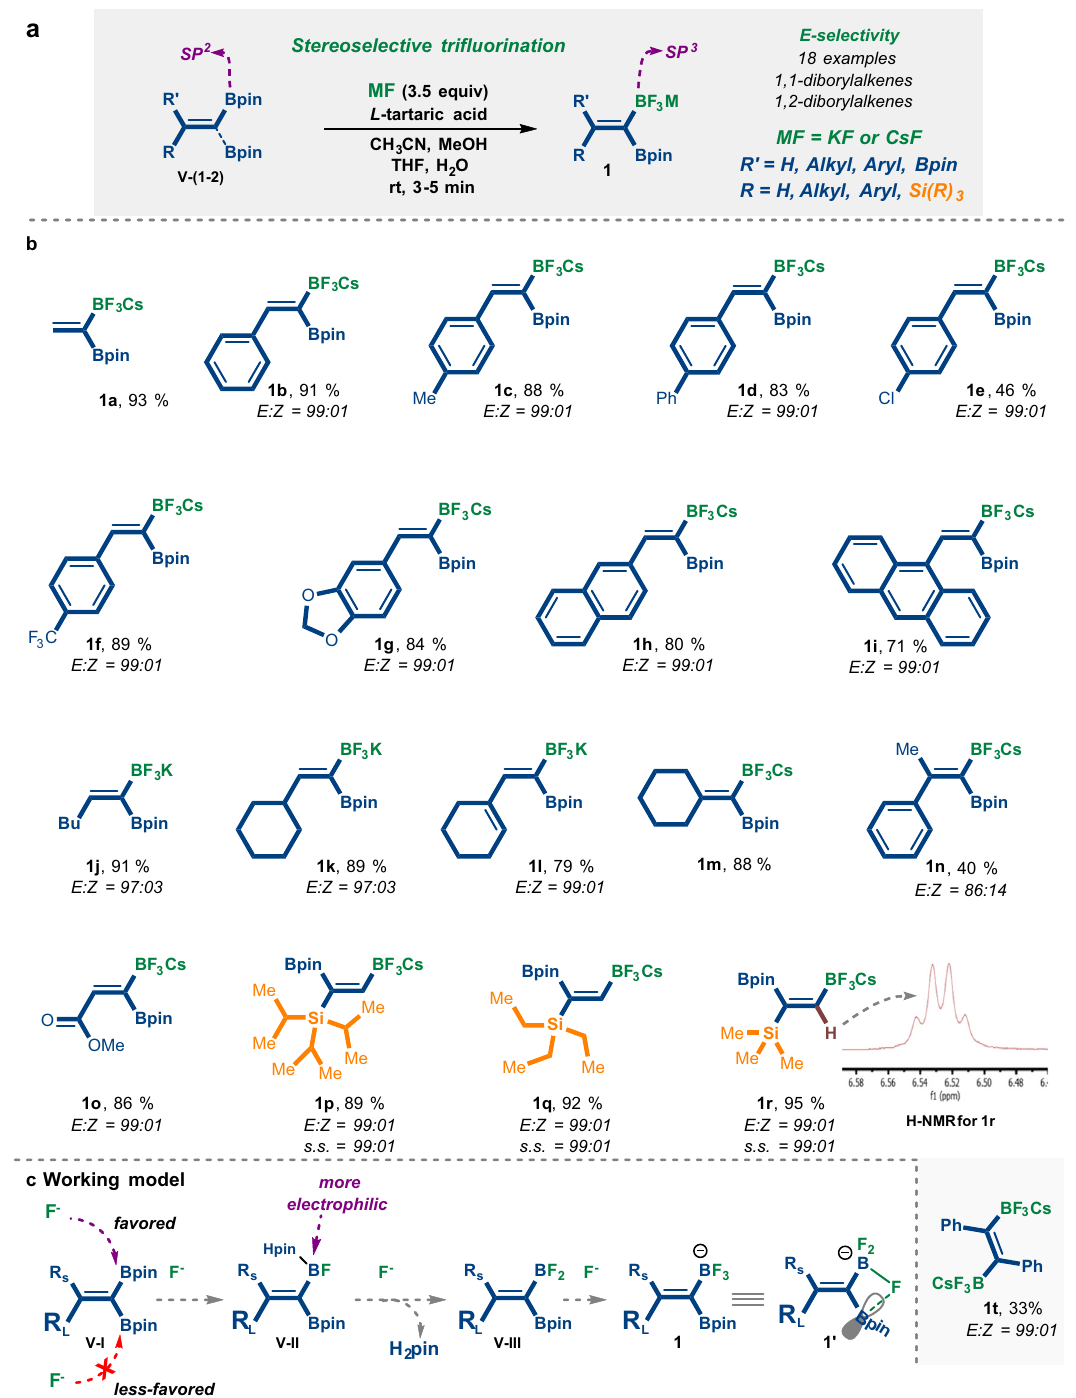
Fig. 2 | The stereoselective tri fl uorination Boron-Masking.a General scheme of the presented tri fl uorination approach. b The scopeof the reaction. c Working model. Bpin pinacolato-boron. s.s.